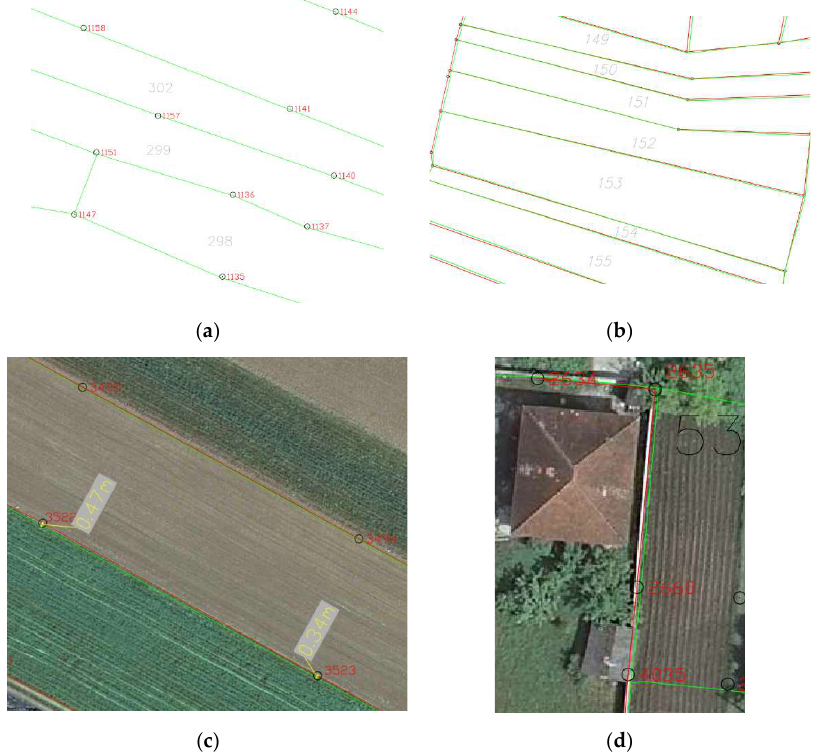
Figure 9. Inconsistencies in cadastral data on land boundaries. ( a ) Calculated coordinates of boundary points from tacheometry (field book) and overlaid with vectorised boundaries (green); ( b ) Connected boundary points for area-based analysis; ( c ) Example of differences in boundary positions—natural boundary; ( d ) Example of differences in boundary positions—man-made boundary.